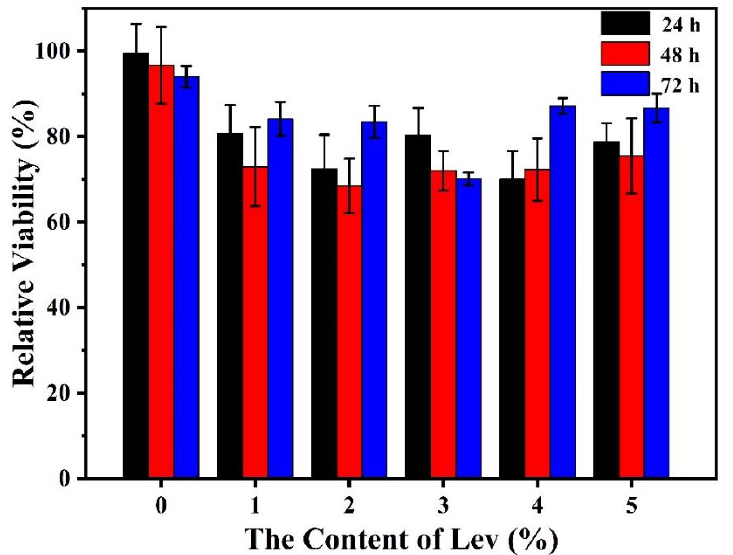
Figure 5. Analysis of relative growth activity of fibroblasts on the gelatin/genipin membranes with different levofloxacin content.